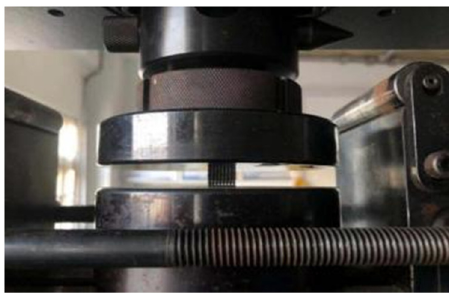
Figure 14: Compression state of specimen reaching compression limit.